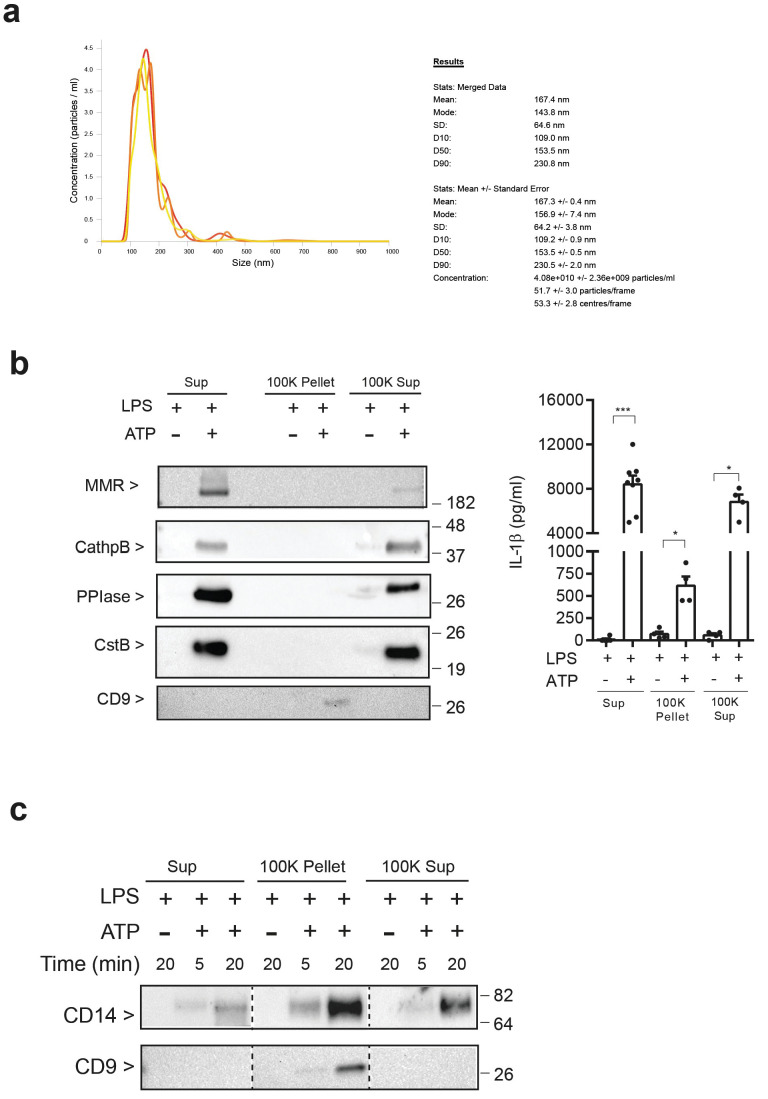
Characterization of P2X7 receptor-induced extracellular vesicles.(a) Nanoparticle tracking analysis of extracellular vesicles isolated from BMDM cell-free supernatant primed for 4 hr with LPS (10 ng/ml) and then stimulated during 20 min with ATP (3 mM); n = 3. (b) Immunoblot for macrophage mannose receptor 1 (MMR), peptidyl-prolyl cis-trans isomerase A (PPIase), cathepsin B (CathpB), cystatin B (CstB) and CD9 (left panel) or ELISA for IL-1β (right panel) in cell-free supernatant (Sup) and fractions (100K pellet and 100K supernatant) obtained from extracellular vesicles isolated from BMDM cell-free supernatant primed for 4 hr with LPS (10 ng/ml) and then stimulated or not during 20 min with ATP (3 mM); results are representative from n = 2 independent experiments (left panel), or n = 4 to 8 independent experiments (right panel); *p<0.05, ***p<0.001, Mann-Whitney test. (c) Immunoblot for CD14 and CD9 in cell-free supernatant (Sup) and fractions (100K pellet and 100K supernatant) obtained from extracellular vesicles isolated from BMDM cell-free supernatant treated for 4 hr with LPS (10 ng/ml) and then stimulated or not at indicated times with ATP (3 mM); representative of n = 3 independent experiments. For b and c numbers on the right of the blots correspond to the molecular weight in kDa.